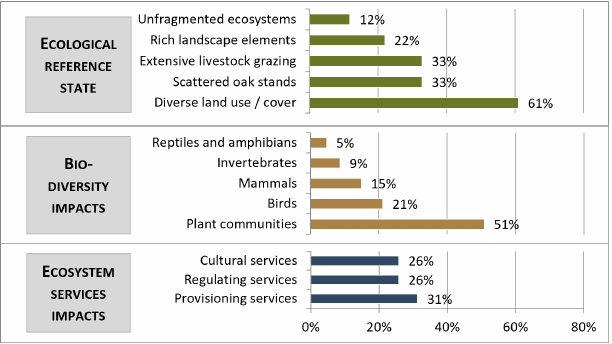
Fig. 7 . Characteristics of the reference state and the impacts of the drivers and pressures on biodiversity and ecosystem services identified in the